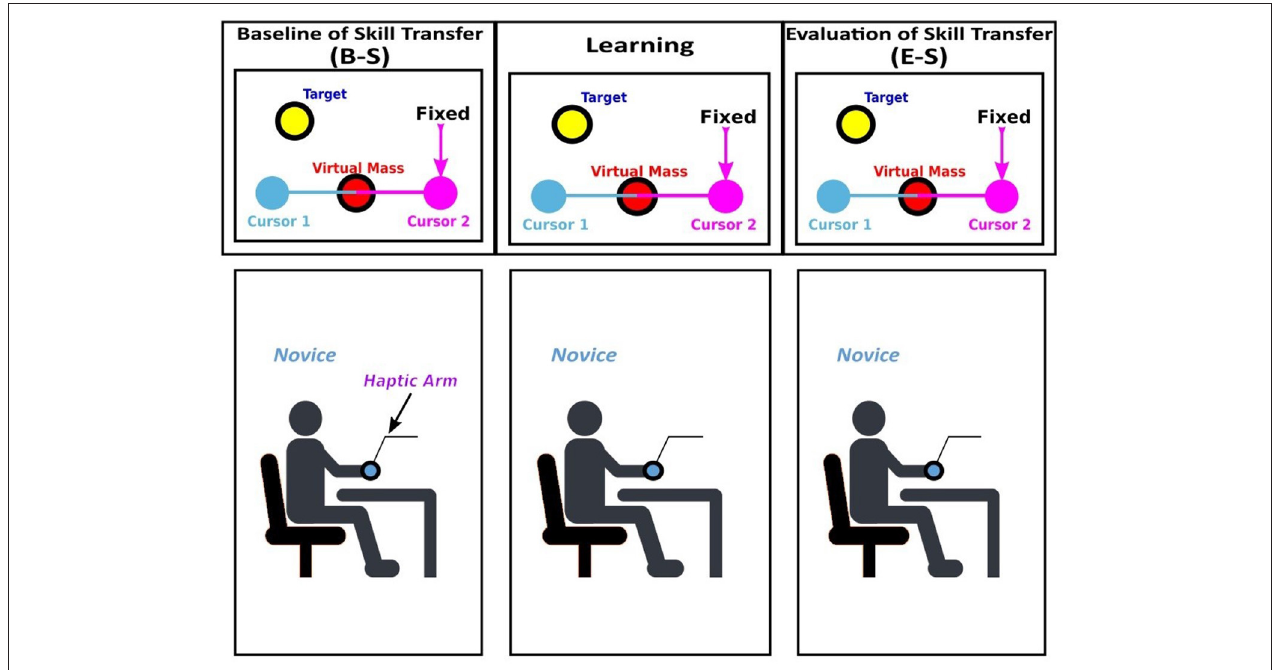
FIGURE 2 | Experimental protocol; the structure of the virtual tool and the experimental phases for the Alone group. Baseline of Skill Transfer (B-S), Learning and Evaluation of Skill Transfer (E-S). In each phase, the position of cursor 2 (purple circle) was fixed at a certain location and the cursor 1 (blue circle) which was correlated with motion of the end-effector of the haptic arm. The novice participant was asked to move a virtual mass (red circle) to the target position (yellow circle) as a single by using the haptic